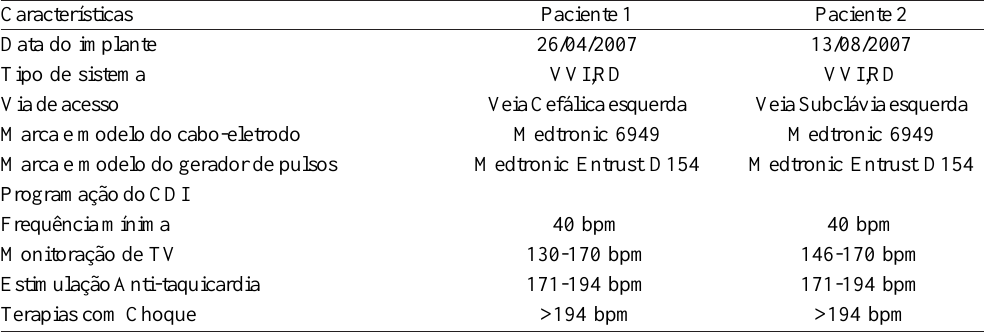
VVIRD= CDI de câmara única; bpm= batimentos por